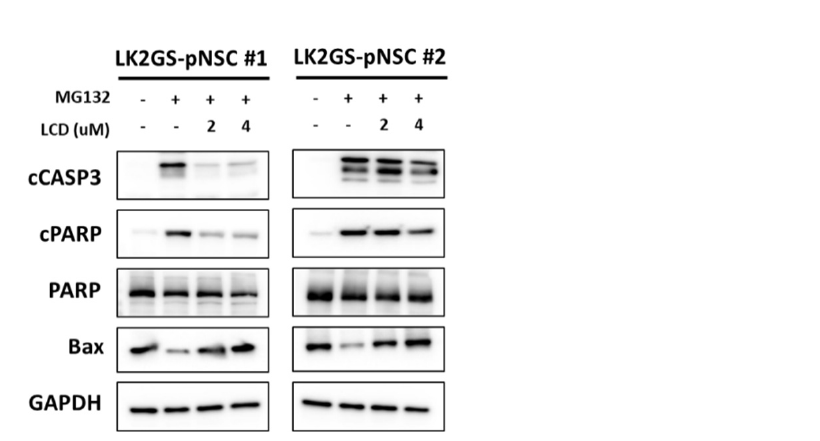
Figure 6. The effect of LCD on the expression of apoptosis-related proteins in MG132-induced LK2GS-pNSCs. The expressions of cCASP3, cPARP, PARP, and Bax were measured by Western blot. GAPDH was used as an internal standard protein.